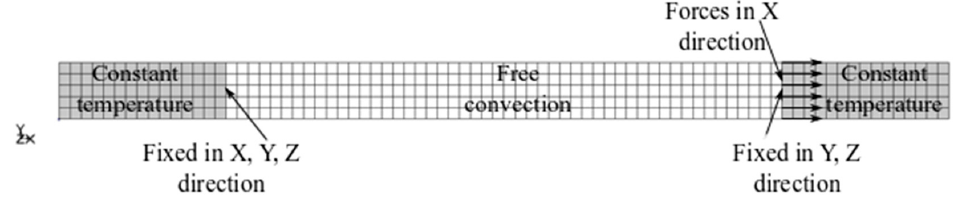
Figure 4. A mesh for the finite element model (FEM) of the SMA specimen showing loading and boundary conditions.